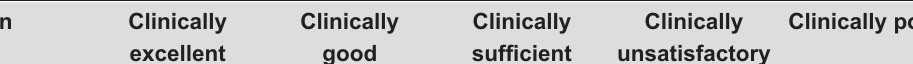
Table 3- Six-months clinical evaluation of restorations: biological n